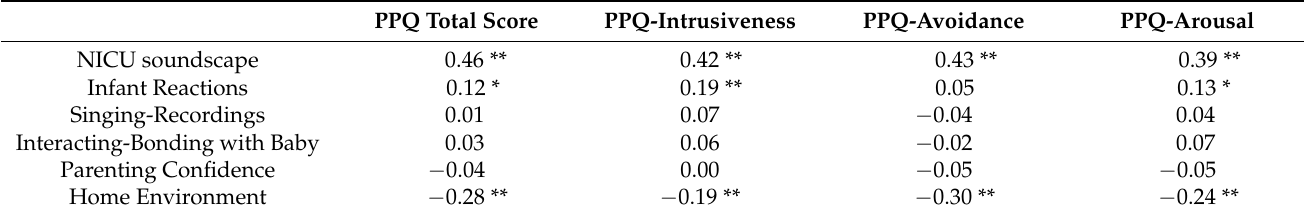
Table 6. Bivariate correlations between birth weight, parental age and all factors of the sound in the neonatal intensive care unit (NICU) questionnaire and all PPQ